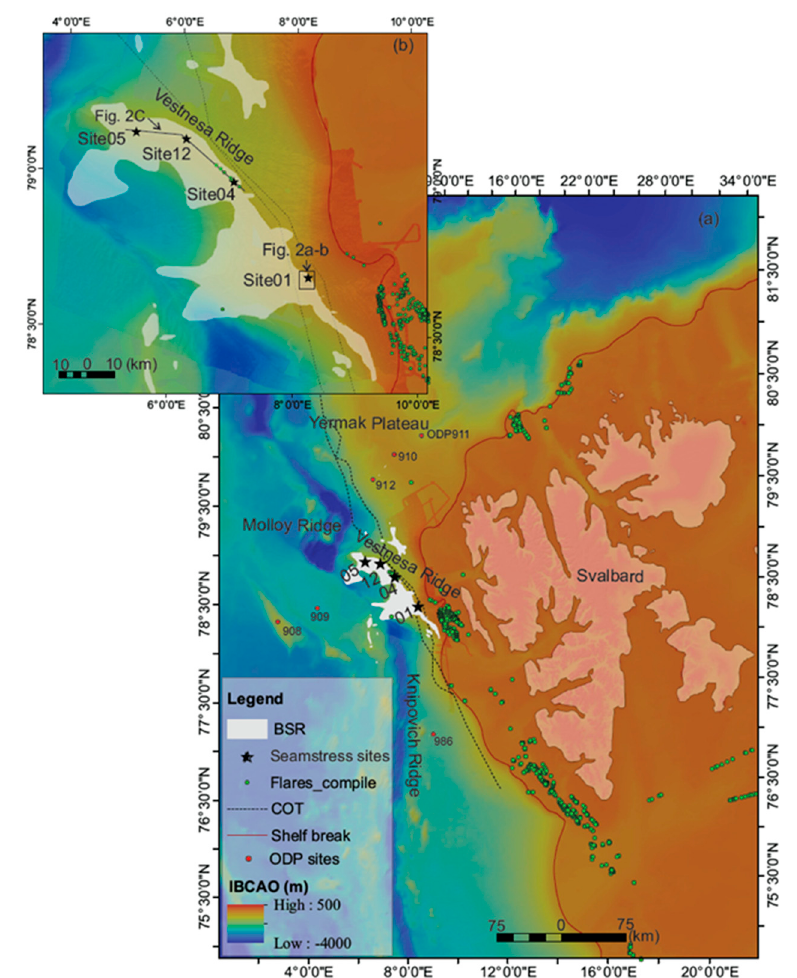
Figure 1. ( a ) Overview map showing the investigated site location on the west-Svalbard continental margin with respect to the distribution of BSRs and mapped seepage expressions. ( b ) Zoom on the VR.